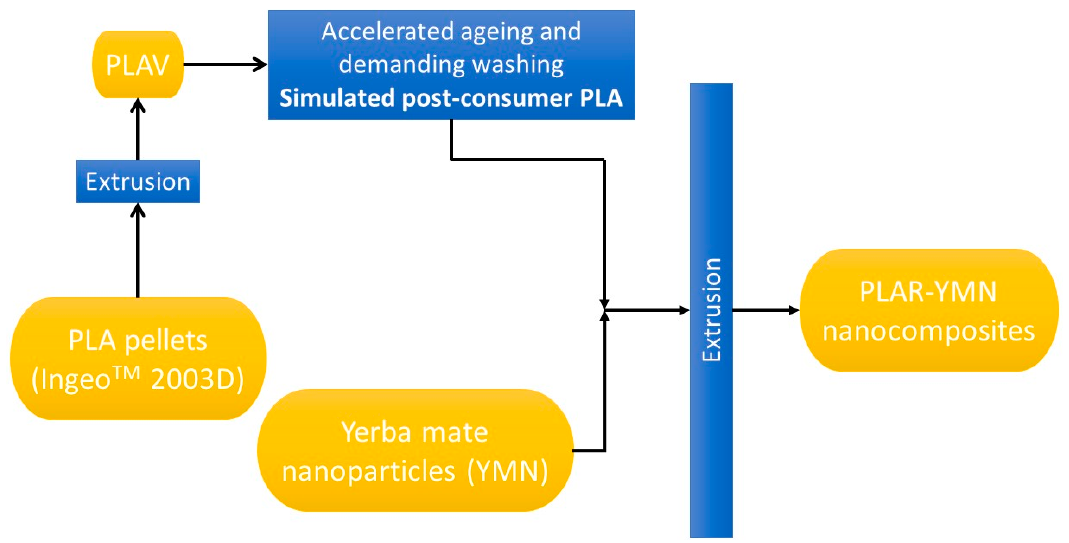
Figure 2. Procedure followed for the obtainment of the PLAR-YMN bionanocomposites.